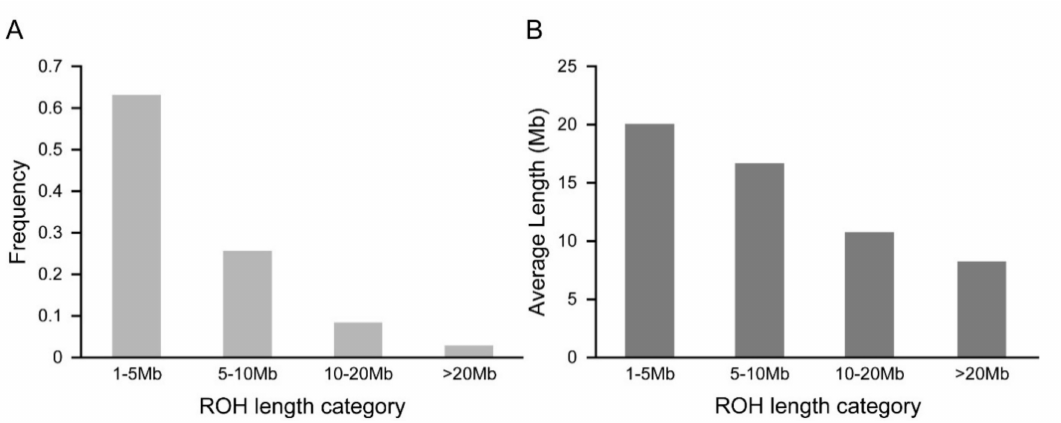
Figure 2. The percent frequency and mean sum of ROH in Chinese Merino under di ff erent length categories. ( A ) The percentage of ROH in the four ROH length categories. ( B ) The mean sum of ROH in the four ROH length